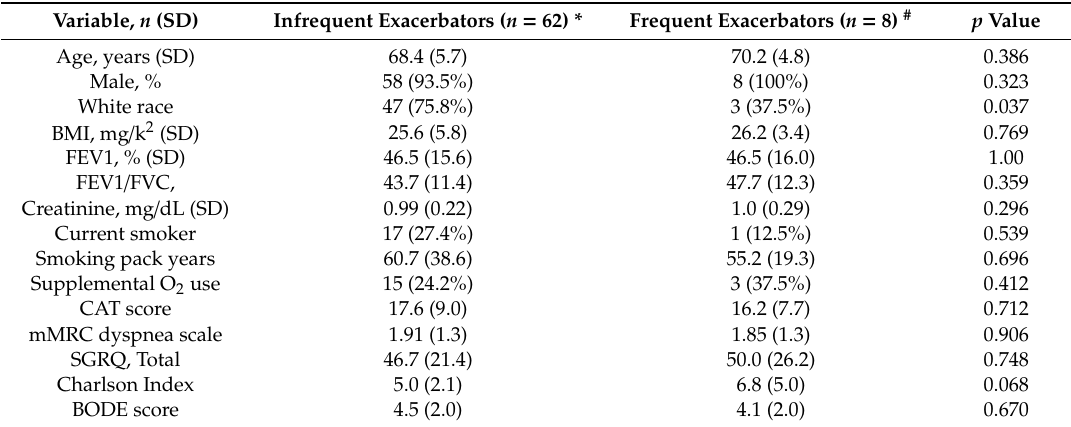
Table 2. Baseline characteristics in groups based on exacerbation frequency.